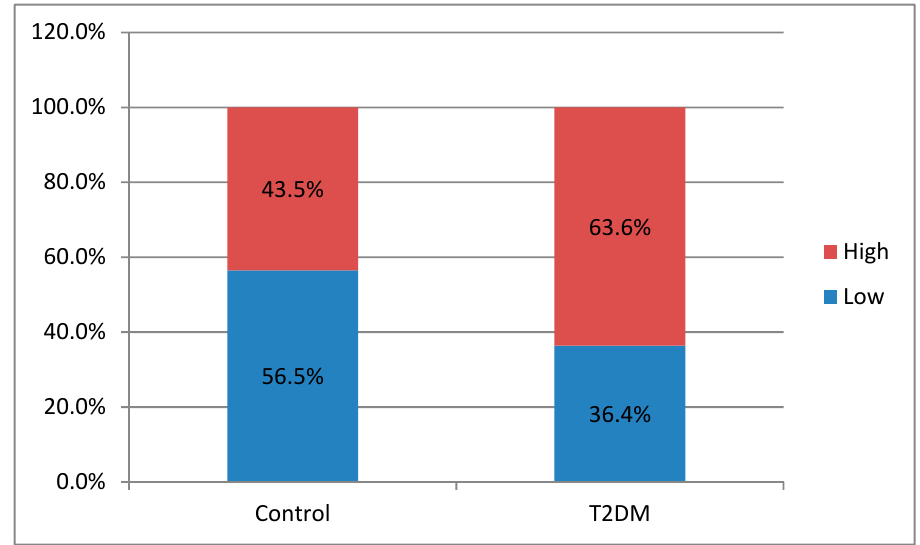
Figure 2. Pro-inflammatory potential after butyrate treatment.